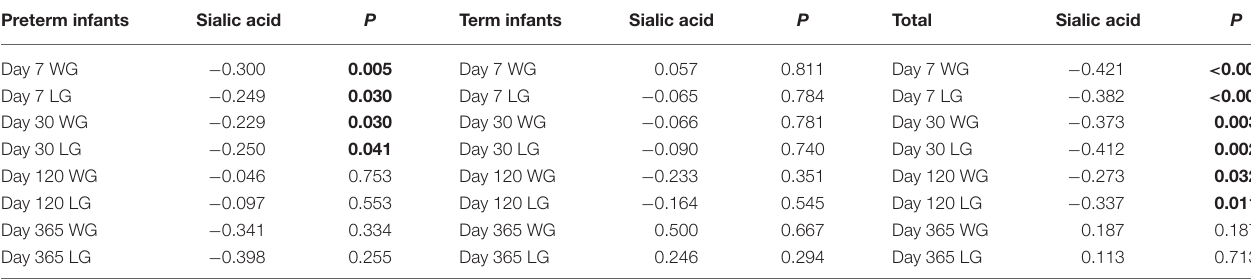
TABLE 3 | Pearson correlation of sialic acids content and infant growth status. Preterm infants